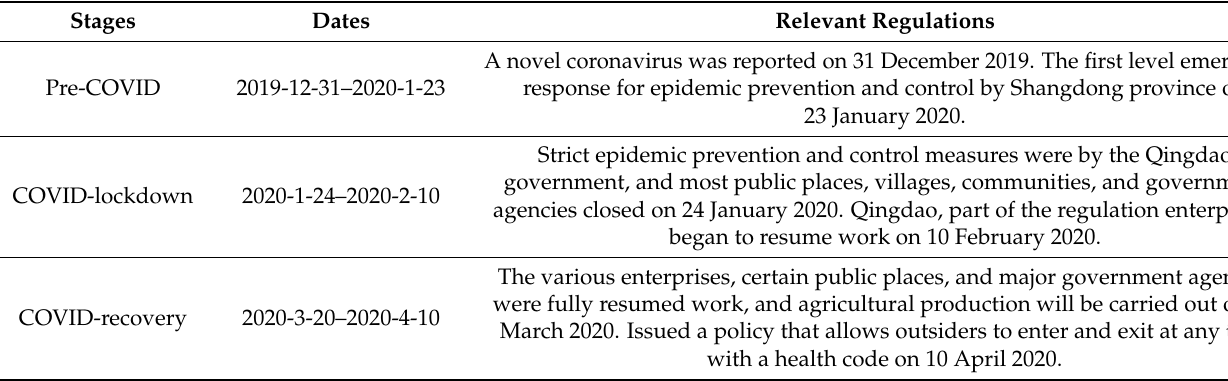
Table 1. Division of stages during the epidemic and relevant